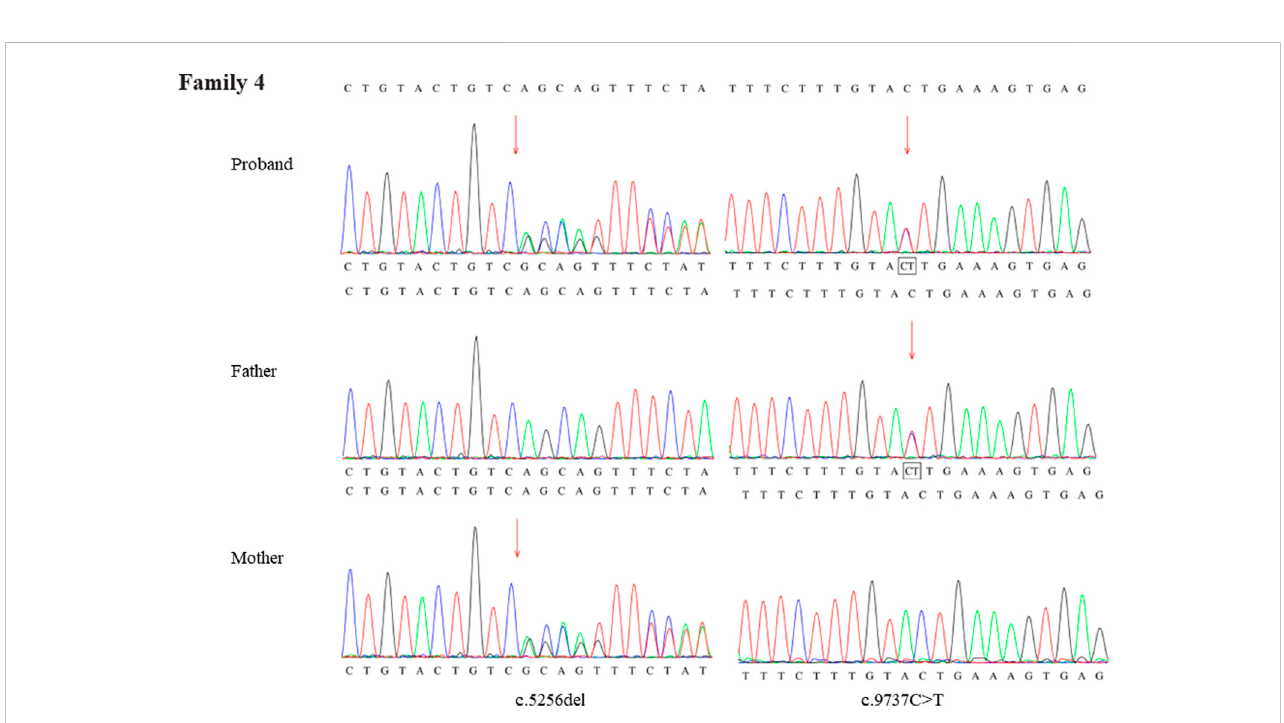
FIGURE 8 Sanger sequence analysis of the mutations of DYNC2H1 gene in the family 4.